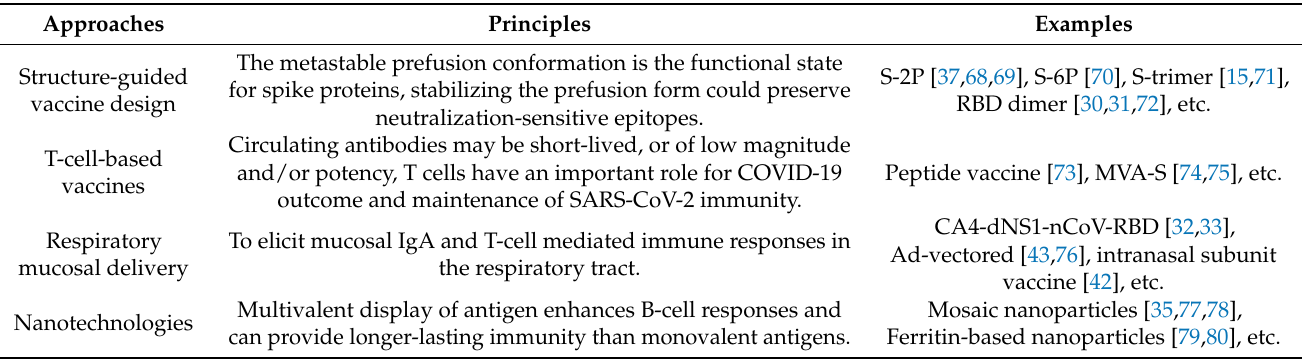
Table 1. Novel vaccine design approaches utilized for SARS-CoV-2 and its